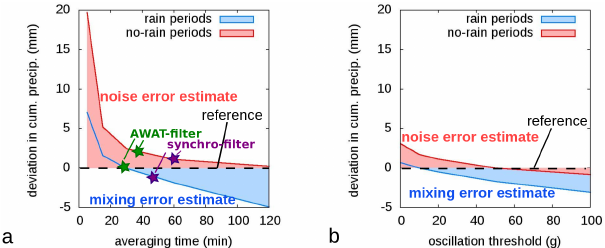
Figure 11. Effects of averaging time (a) and oscillation threshold value (b) on the estimates for the mixing error and the noise error. The error estimates of the AWAT filter and the synchro filter are indicated in panel (a) with green stars for the AWAT filter and purple stars for the synchro